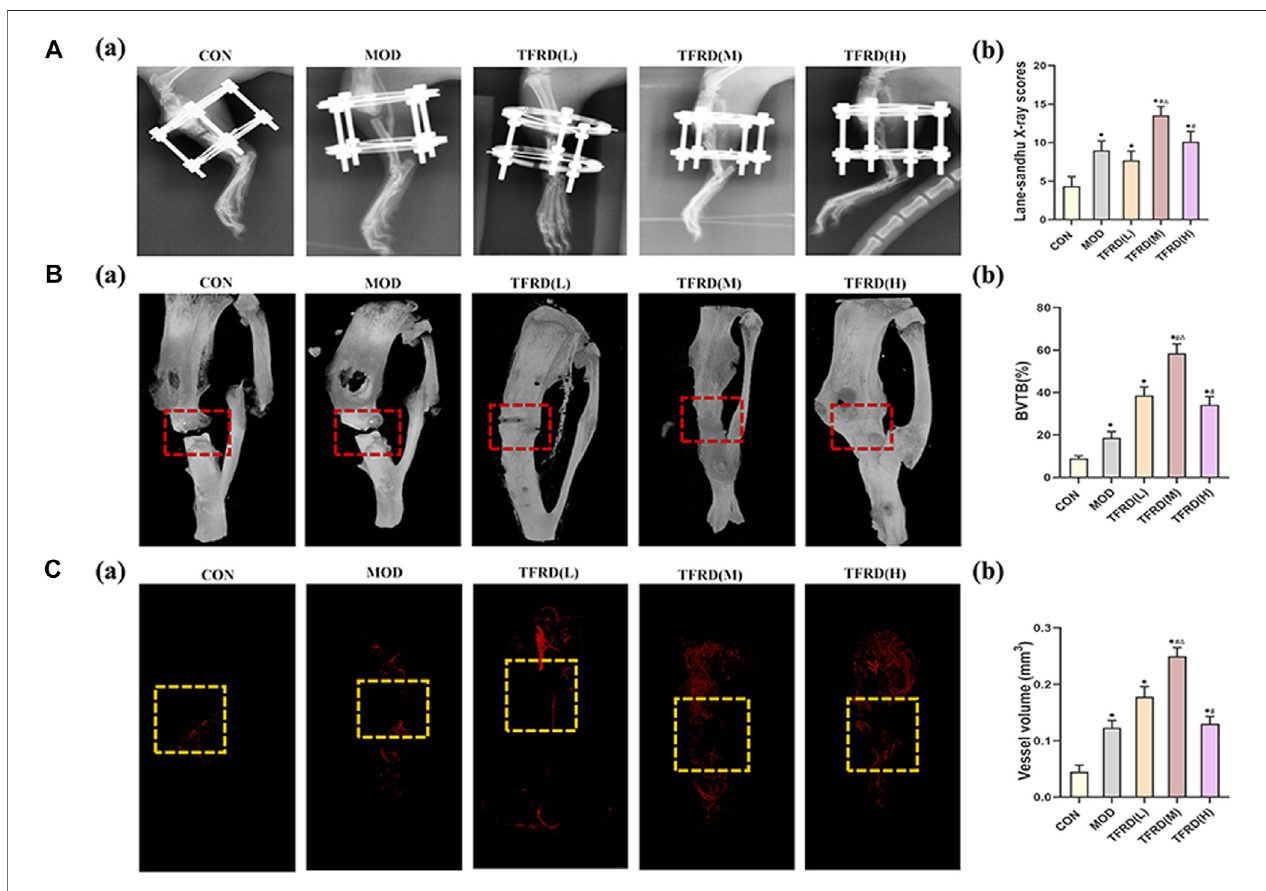
FIGURE 3 | Evaluation of radiological, micro-CT images, angiogenesis of tibial bone repair of fi ve groups (A) . Radiological evaluation of bone repair (A) (a). Representative radiographsofbonerepairofthe fi vegroupsat12 weeksaftersurgery( n (cid:1) 3pergroup); (A) (b).Quantitativeanalysisofradiographicscores (B) .Representativemicro-CTimagesofbone repair (B) (a).Three-dimensionalreconstructedimagesofbonedefectsat12 weeksaftersurgicaldottedboxesindicateregionofinterest(ROI),representingbonedistractedgaps( n (cid:1) 3 pergroup); (B) (b).Quanti fi cationofbonetissuevolume/totaltissuevolumeand(BV/TV)insidesbonedistractedregions (C) .Evaluationofangiogenesiswithinthedistractedgapsat 4 weeksaftersurgery (C) (a).Representativeangiographsofthedistractedgapsinthe fi vegroups( n (cid:1) 3pergroup) (C) (b).Quanti fi cationofvesselvolumewithinthedistractedregions (yellow dotted boxes indicate region of interest (ROI), representing bone distracted gaps). The data are expressed as the mean ± SEM of three independent experiments. * p < 0.05, comparedwiththecontrolgroup; # p < 0.05,comparedwiththemodelgroup; △ p < 0.05,comparedthedifferenceofthemediumdosewiththelowandhighdosesintheTFDRgroup.